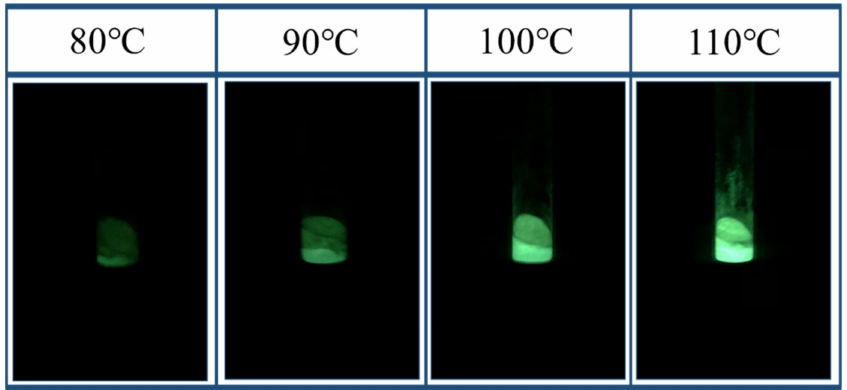
Figure 5. Fluorescence effect of TSF microcapsules excited by different